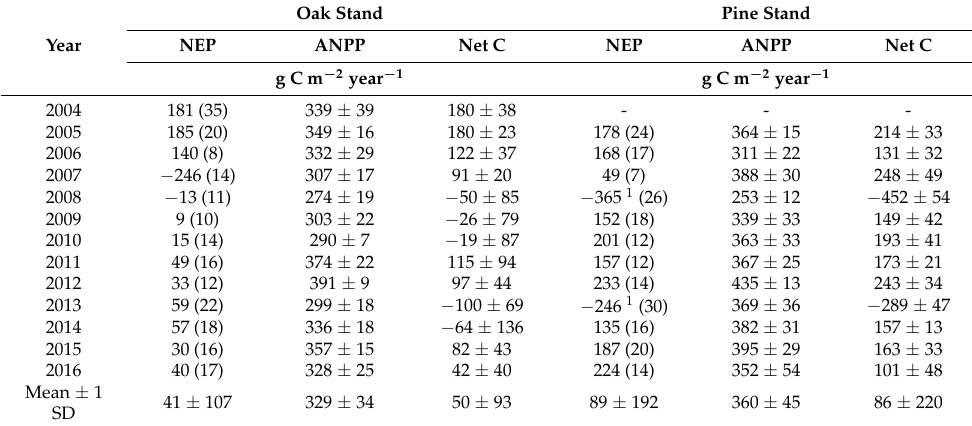
1 Includes combustion losses of 442 ± 43 g C m − 2 in 2008 and 399 ± 52 g C m − 2 in 2013 documented in [35]. SD: standard deviation.